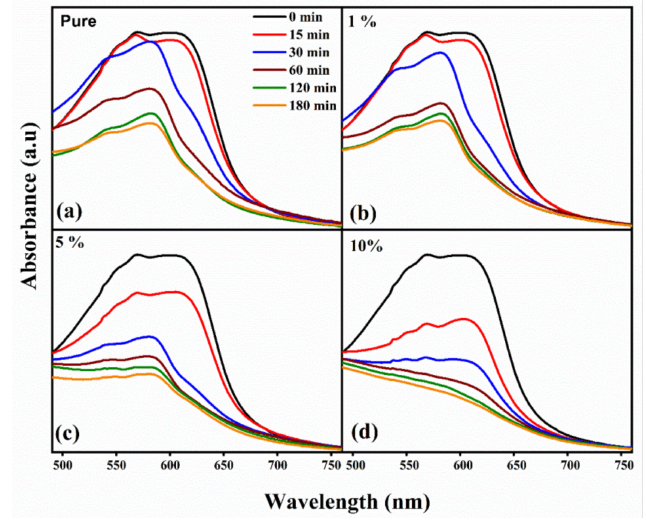
Figure 7. Absorption vs. wavelength spectra for the photocatalysis of Rz ink on the surface of POP–BiF 3 (%) composites with the variation of BiF 3 concentration ( a ) 0%, ( b ) 1%, ( c ) 5%, and ( d ) 10% in POP matrix.